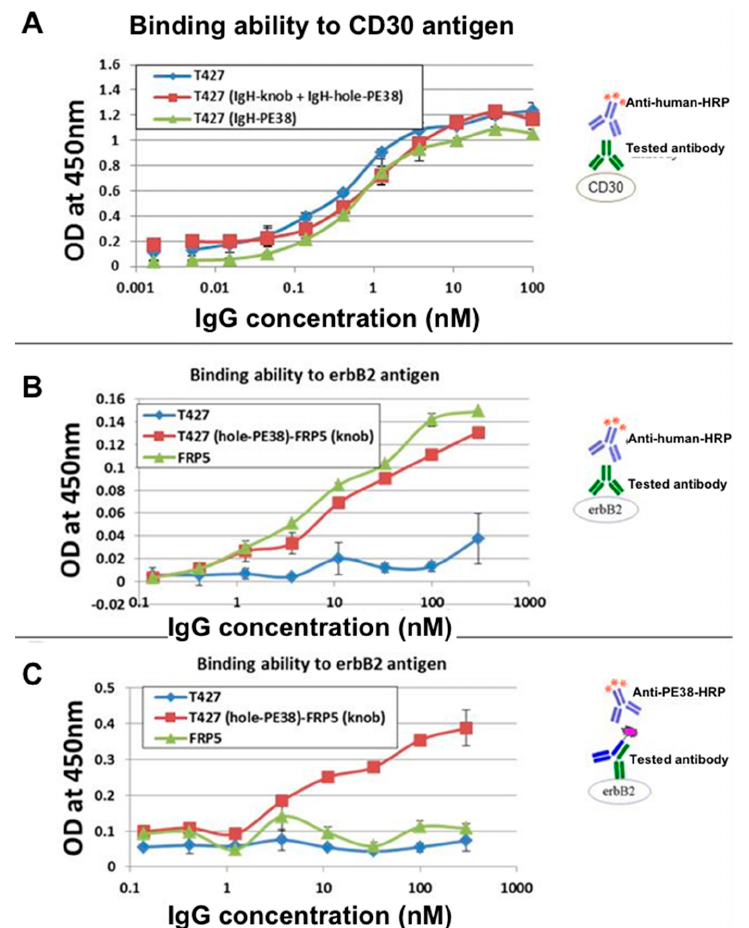
Figure 4. Evaluation of antigen binding by refolded IgGs and IgG-KIH derivatives. ( A ) Evaluation by ELISA of CD30 binding by T427 IgG and T427-PE38 (PE38 fused to each heavy chain) in comparison to the KIH version of T427; ( B ) Evaluation by ELISA of ErbB2 binding by KIH FRP5-T427-PE38 (Light chain-FRP5 + Light chain-T427 + Heavy chain-FRP5-knob+Heavy chain-T427-hole-PE38) compared to the parental IgGs; ( C ) Evaluation by ELISA of heavy chains heterodimer formation. The KIH T427-FRP5 PE38 IgG bound ErbB2 (binding by the FRP5-knob heavy chain) and its T427-hole-PE38 was identified by anti-PE38 antibodies.